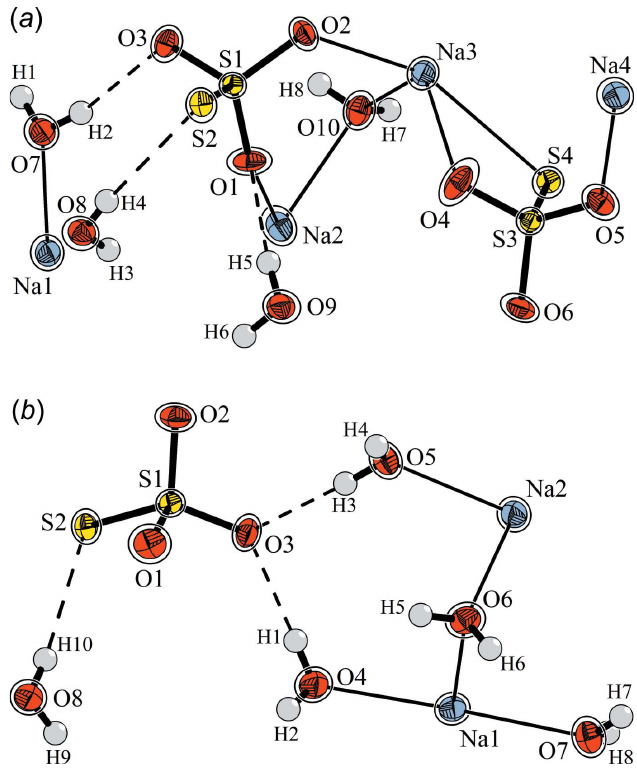
Figure 1 The asymmetric units ( a ) of Na 2 S 2 O 3 (cid:2) 2 H 2 O, and ( b ) of Na 2 S 2 O 3 (cid:2) 5 H 2 O, with a comparison of relative positions and displacement ellipsoids of the non-hydrogen atoms obtained from structure determinations at 100 K (filled atoms) and at 200 K (contours of ellipsoids drawn around filled atoms). Ellipsoids are drawn at the 80% probability level, hydrogen bonds as dashed